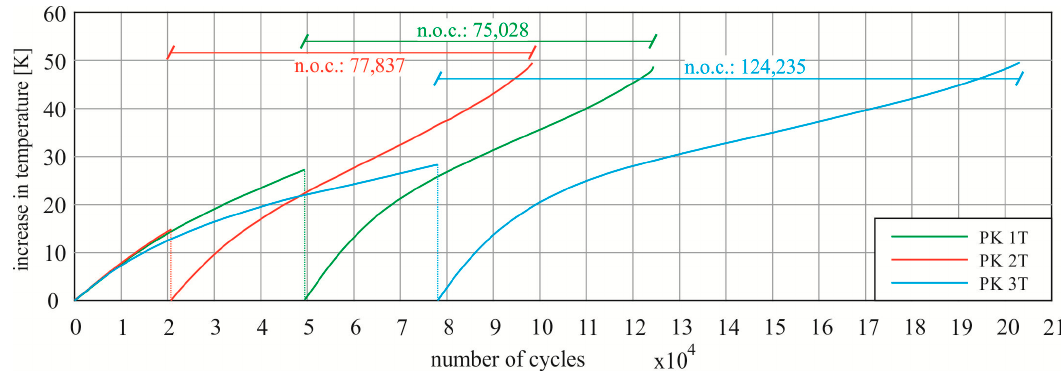
Figure 8. Temperature increase inside the specimen for the first and the second fatigue loading, test conditions: frequency f P = 10 Hz, relation between lower and upper stress level S c,min /S c,max = 0.1/0.7.